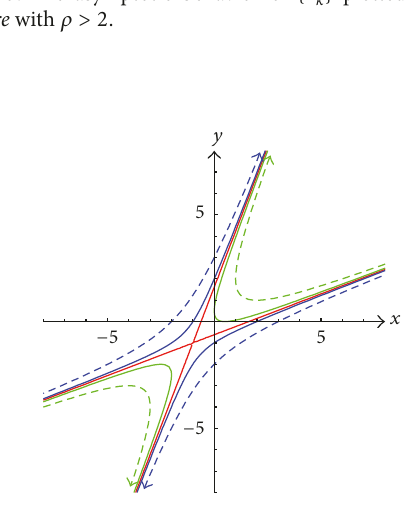
Figure 14: The asymptotic behavior of {𝑃 𝑘 } plotted by Tracking Procedure with 𝜌 < −2